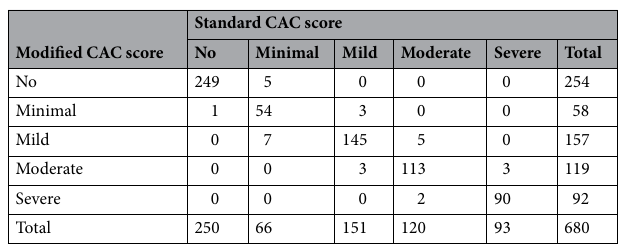
Table 3. Agreements for risk categories between the standard and modified CAC scores from the training set (κ = 0.943). Data are absolute participant numbers. CAC coronary artery